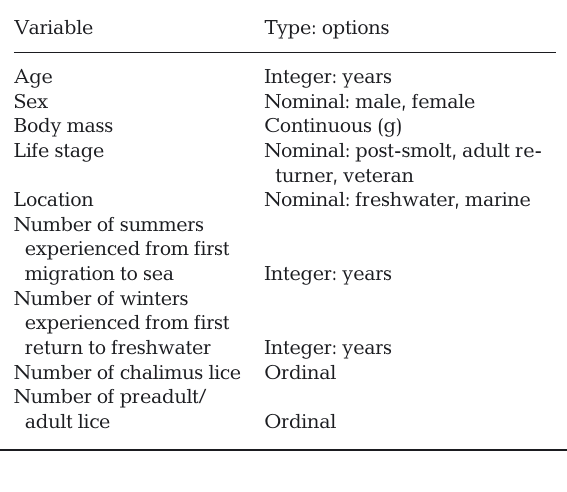
Table 1. State variables of sea trout